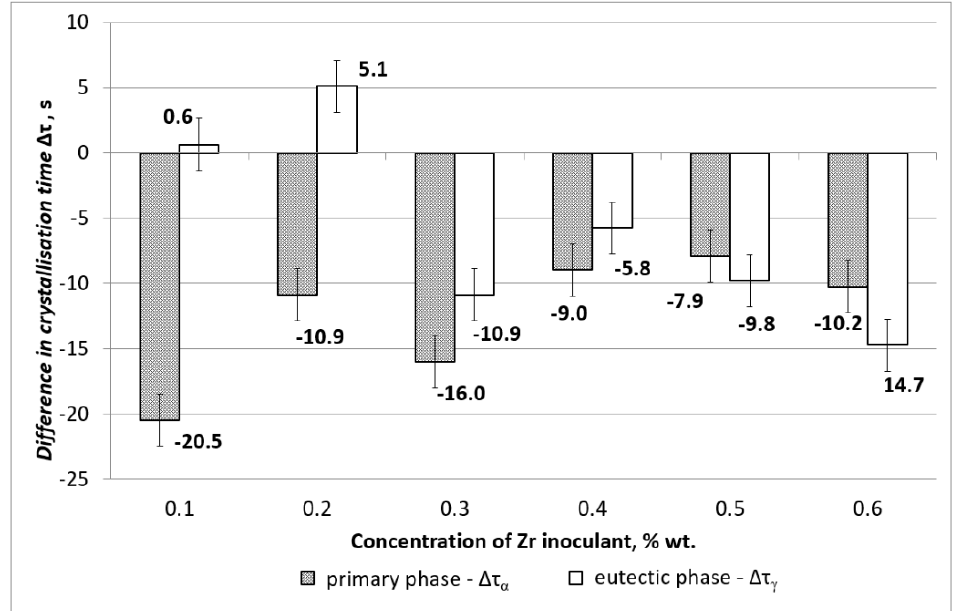
Figure 2. Difference in the solidification time of phase α Mg and eutectic α Mg + γ (Mg 17 Al 12 ) of the Zr-inoculated magnesium alloys in reference to the baseline AZ91 alloy.